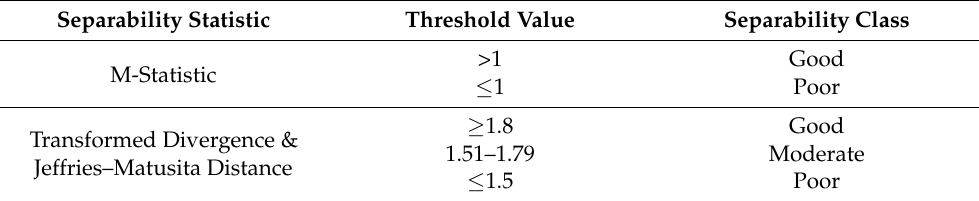
Table 1. Separability threshold values (based on Kaufman and Remer [64], Campbell [74], and Bindel et al. [75]). Separability Statistic Threshold Value Separability Class >1 Good M-Statistic ≤ 1 Poor ≥ Transformed Divergence &